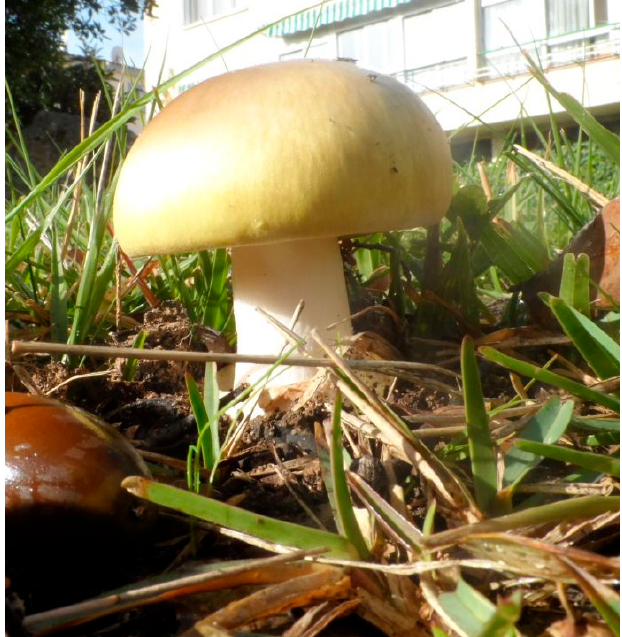
Figure 1. Amanita phalloides , cause of the deadly phalloidin syndrome.